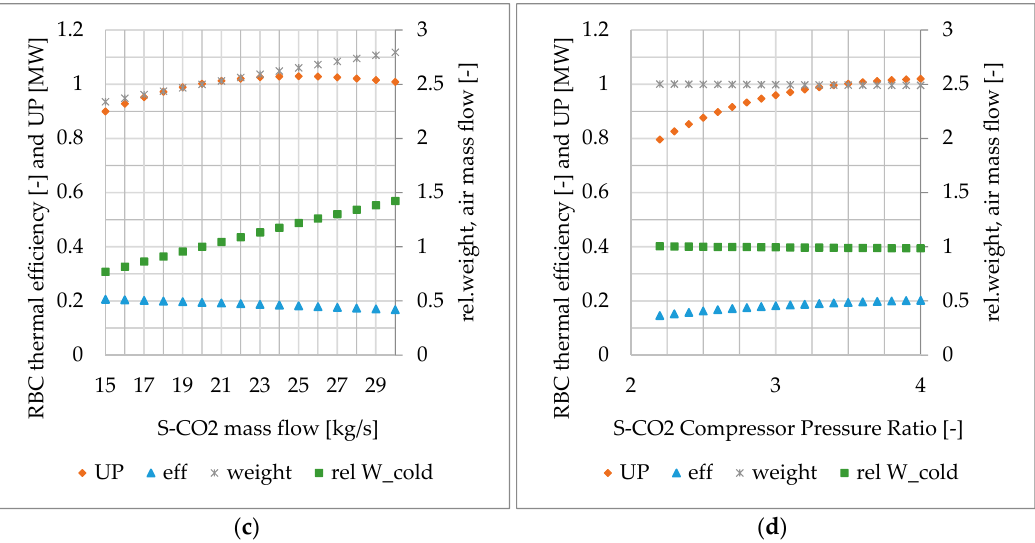
Figure 9. Effect of the compressor inlet temperature and pressure on: the produced shaft power (UP) ( a ); and the cycle weight ( b ). The influence of: the S-CO2 mass flow ( c ); and pressure ratio ( d ).